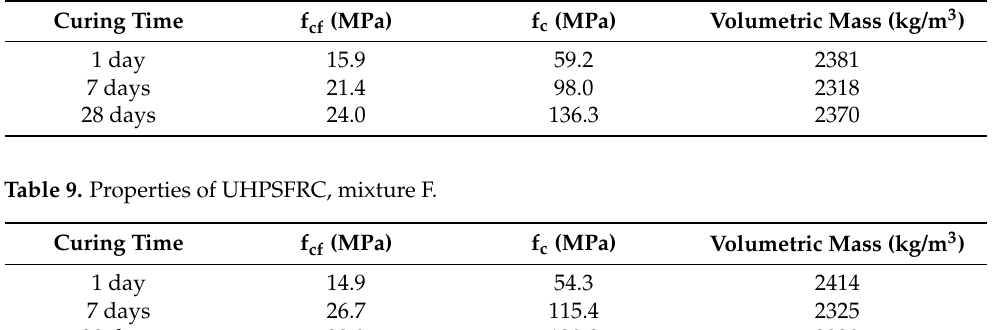
Table 8. Properties of UHPSFRC, mixture E.